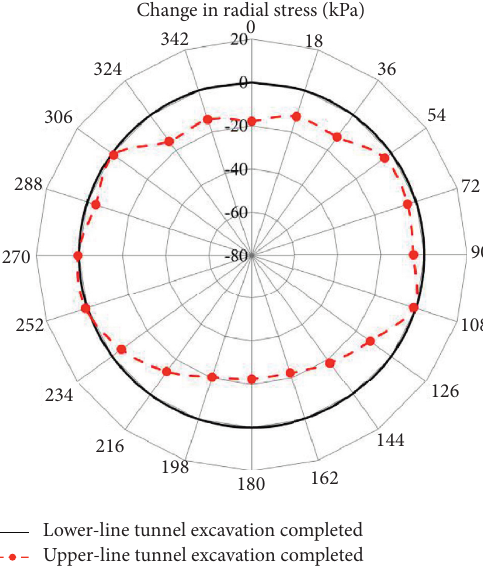
Figure 11: Change in the radial stress.